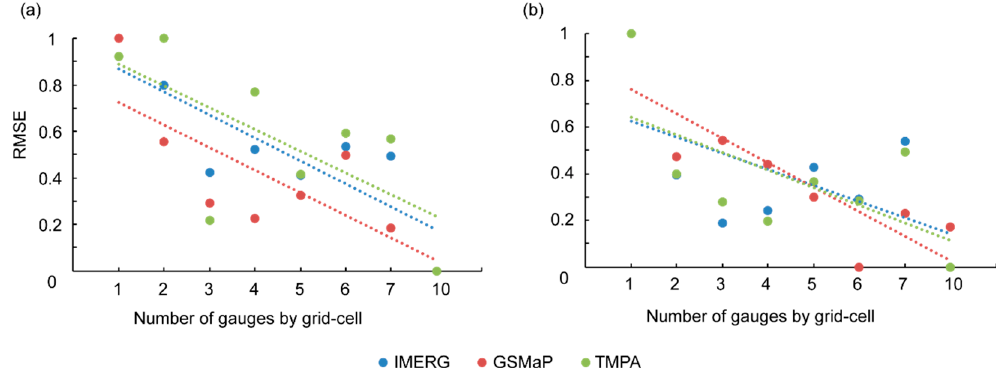
Figure 6. Gauges number influence onto the SPEs accuracy expressed in term of normalized RMSE between 0 and 1. The analysis is applied for the 0.25° grid-cells scale at both daily ( a ) and monthly; ( b ) time step. Dotted line shows the linear trends.